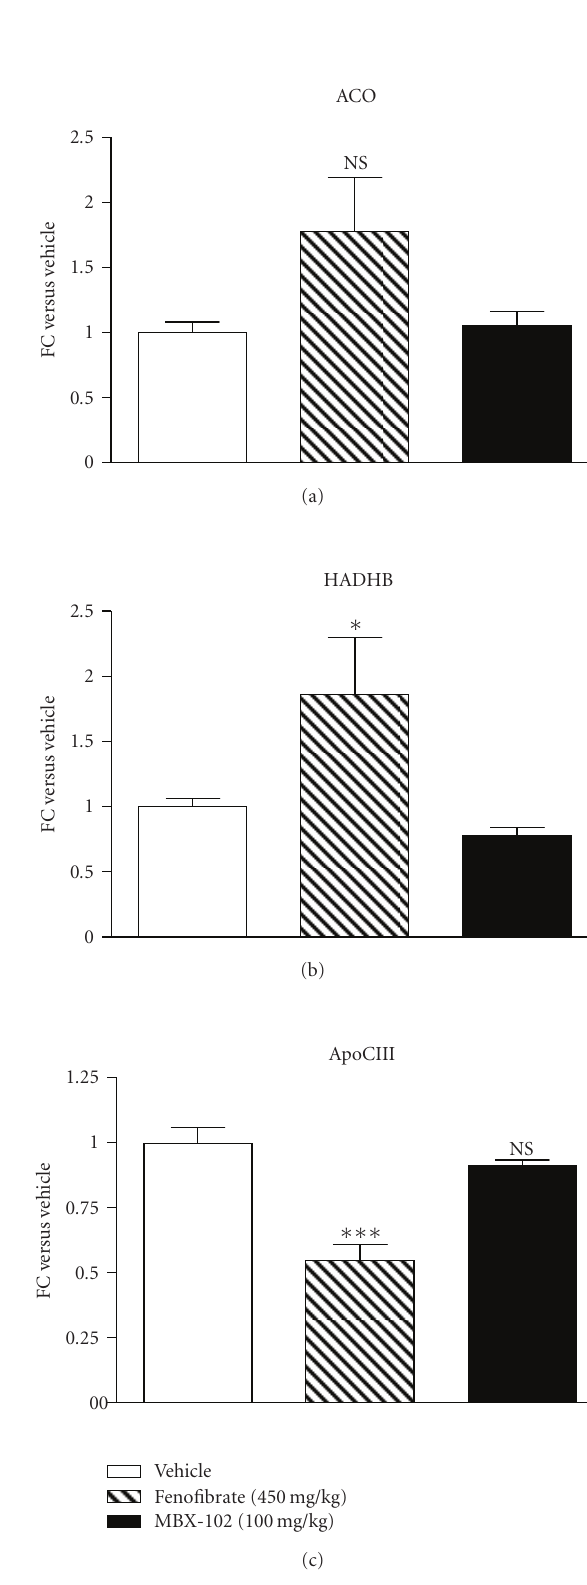
Figure 6: Gene expression levels of PPAR- α responsive genes in livers derived from male ZF rats treated for 32 days with either MBX-102 (100mg/kg) or fenofibrate (450 mg/kg). Expression levels of ACO (a), HADHB (b), and apoC-III (c) mRNA. Values represent mean ± SEM (NS: P > . 05, ∗∗∗ : P < . 001 versus Vehicle-treated, 1-way ANOVA, and Newman-Keuls multiple comparison